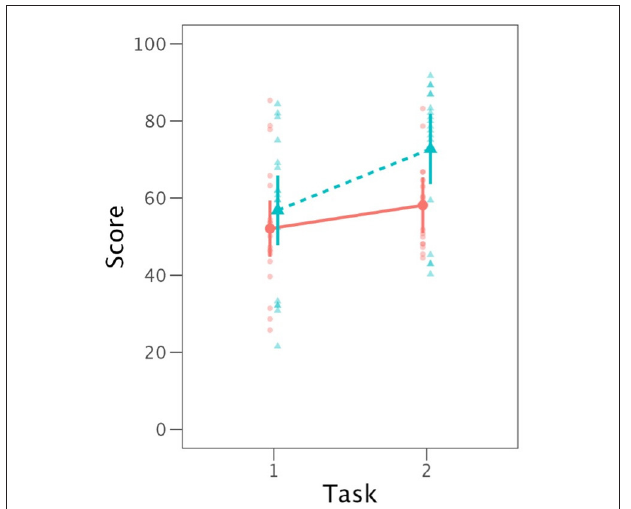
FIGURE 1 | Mean vowel intelligibility (with 95% CI) according to task (1 = PNam, 2 = IntRep) and matching status (solid line = match, dotted line = no match).